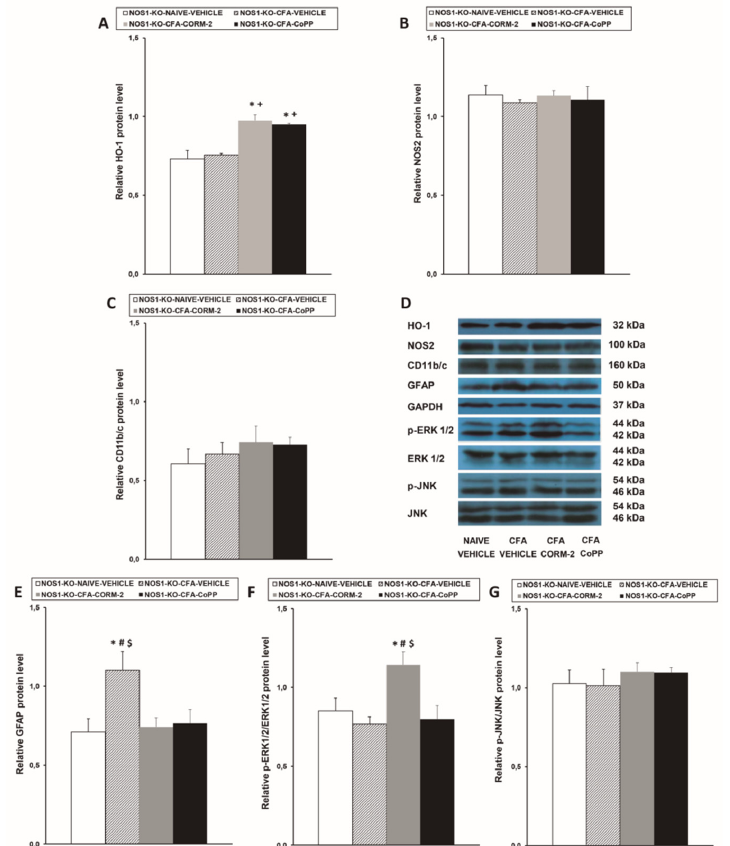
Figure 3. E ff ects of CoPP and CORM-2 on the protein levels of HO-1, NOS2, CD11b / c, GFAP, p-ERK 1 / 2, and p-JNK in the LC of NOS1-KO mice. Protein levels of HO-1 ( A ), NOS2 ( B ), CD11b / c ( C ), GFAP ( E ), p-ERK 1 / 2 ( F ), and p-JNK ( G ) in the LC of CFA-injected NOS1-KO mice treated with vehicle, CORM-2, or CoPP are represented. These levels from naïve mice treated with vehicle are also represented as controls. In all panels, * represents significant di ff erences vs. naïve vehicle-treated mice, + represents significant di ff erences vs. CFA-injected mice treated with vehicle, # represents significant di ff erences vs. CFA-injected mice treated with CORM-2, and $ represents significant di ff erences vs. CFA-injected mice treated with CoPP ( p < 0.05, one-way ANOVA, Student–Newman–Keuls test). Examples of western blots for HO-1(32 kDa), NOS2 (100 kDa), CD11b / c (160 kDa), GFAP (50 kDa), GAPDH (37 kDa), p-ERK 1 / 2 / total ERK 1 / 2 (42–44 kDa), and p-JNK / total JNK (46–54 kDA) are shown ( D ). The levels of phosphorylated proteins are relative to the total levels of the corresponding proteins, while the levels of the remaining proteins are relative to those of GAPDH. Results are expressed as mean ± SEM; n = 4 samples per